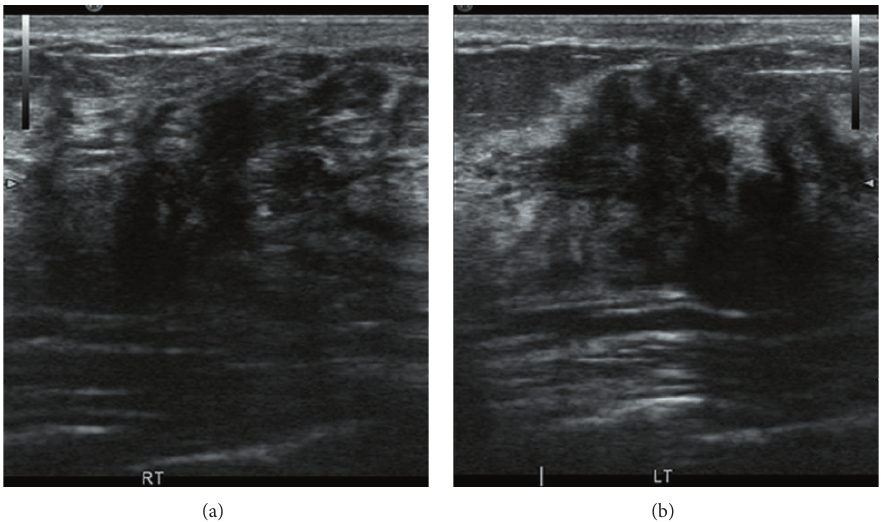
Figure 2: The ultrasound examination demonstrated a solid hypoechoic mass with an irregular shape and a lobulated margin both in the upper outer quadrant of the right breast (a) and below the nipple of the left breast (b).